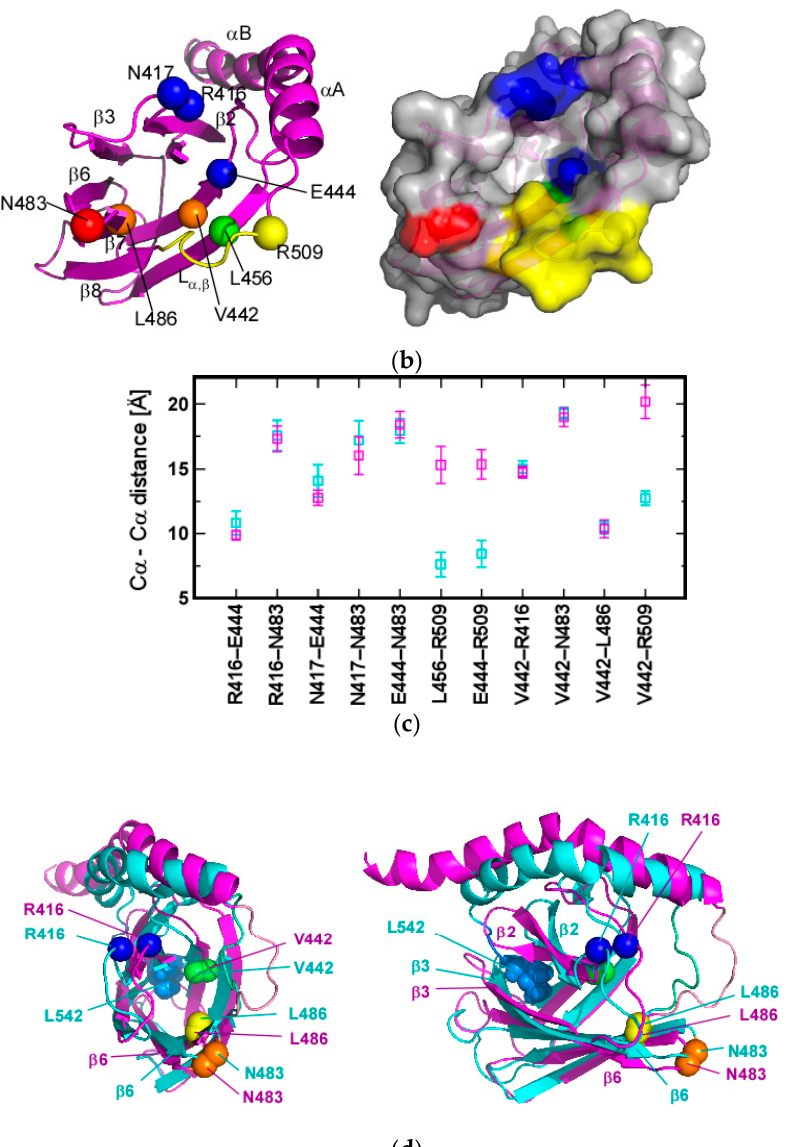
Figure 7. Structural changes to residues located at the interdomain interface. ( a ) The C α positions of residues engaged in the interaction with NBD: the C α atoms for the annotated residues are shown by spheres on the structure of SBD( ∆ CDE) ( left ). A surface plot of the structure is shown in the left panel ( right ); ( b ) The corresponding residues marked in SBD( ∆ CDE) are shown in the structure of SBD( ∆ CDE)-y ( left ) with its surface plot ( right ); ( c ) C α distance distributions for pairs of residues among the NMR ensemble of SBD( ∆ CDE) (cyan) and SBD( ∆ CDE)-y (magenta); ( d ) Structural comparison between SBD( ∆ CDE) (cyan) and SBD( ∆ CDE)-y (magenta) demonstrates the C α position changes for pivotal residues engaged in interdomain interactions.